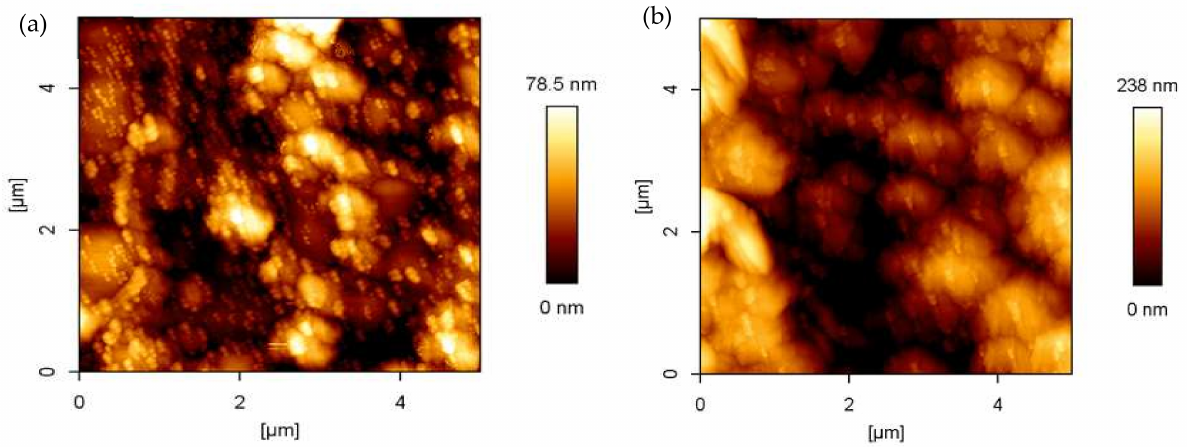
Figure 8. Oxide surface roughness of C1020 ( a ) at RT and ( b ) annealed at 400 ◦